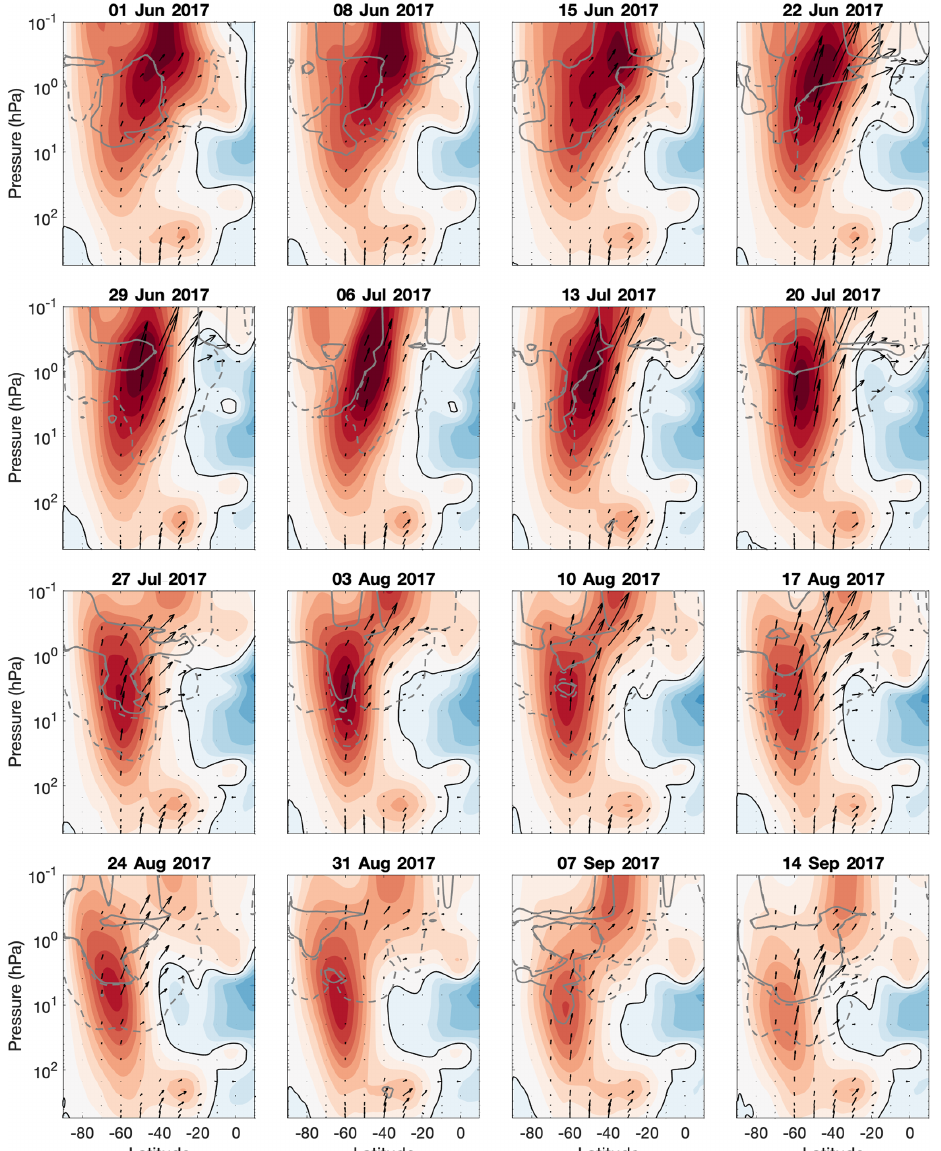
Figure A2. The same as Fig. 1 but for the year